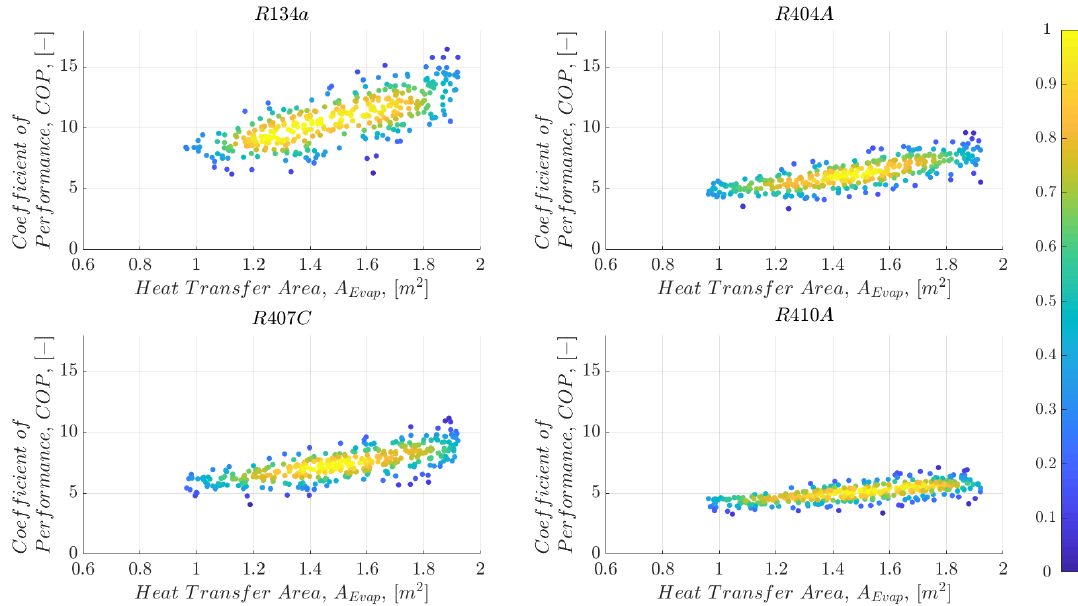
Figure 29. Probability density estimation of the heat transfer area as a function of the coefficient of performance for all the working fluids employed.